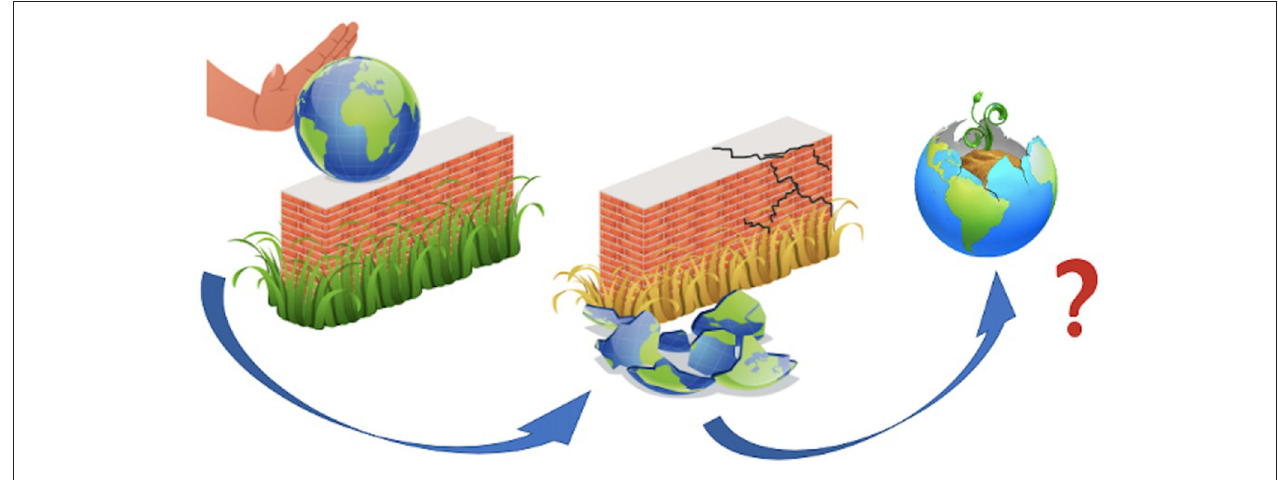
FIGURE 1 | Schematic of our Humpty Dumpty Earth. Left, a past period; center, a fractured twenty-second century Earth on a cracked foundation; right, reassembled Earth accompanied by